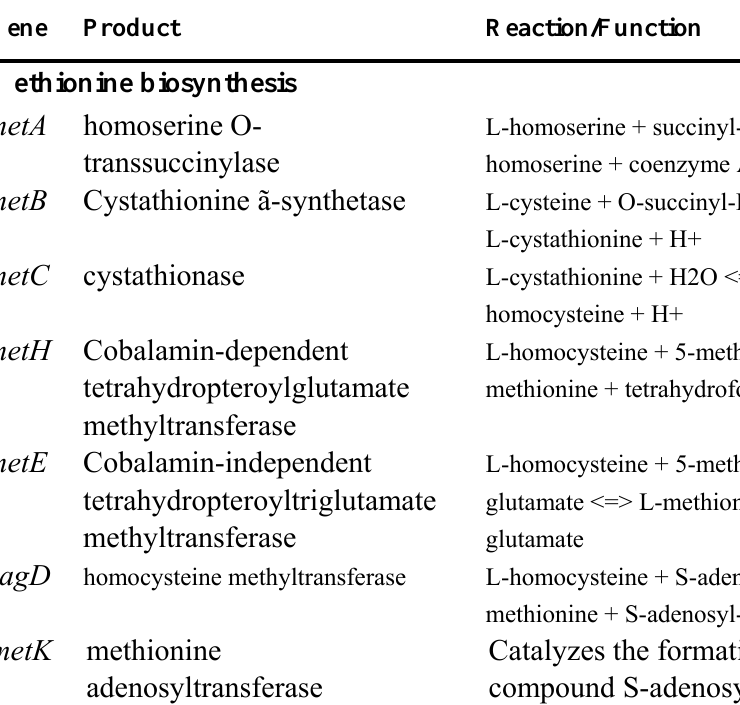
Table 1 . Summary of genes which participate in methionine biosynthesis and regulation. Gene Product Reaction/Function